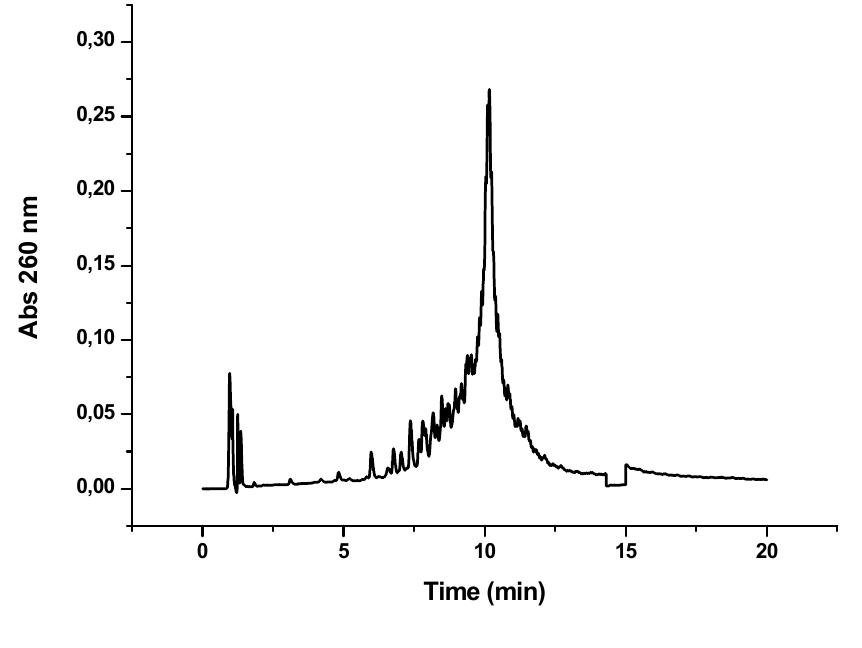
Figure 5. HPLC profile obtained after the synthesis of OPC-7 (CFFCP1-Y-T wavelength 260